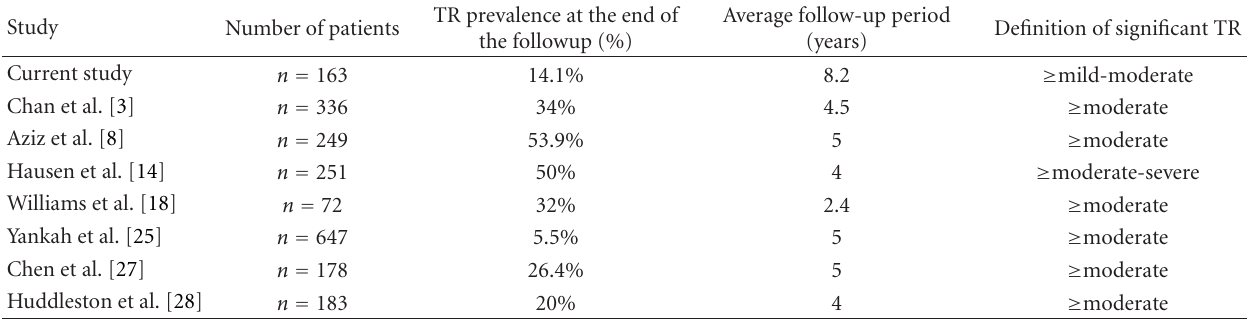
Table 5: Prevalence of TR after OHT.